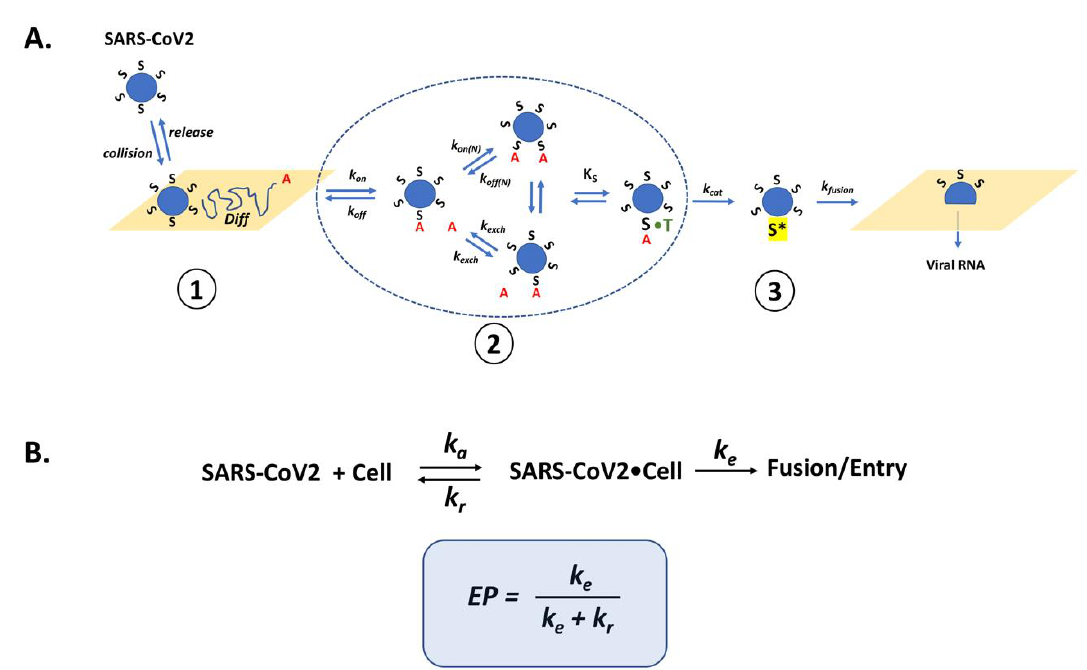
Figure 4. Kinetic Model of SARS-CoV2 Cell Interactions. (A) The model is presented as the composite of three general processes: (1) Initial collision and release from the cell surface (represented by the yellow plane) coupled to random diffusion. (2) Reversible binding of Spike protein (S) to ACE2 ( A ) (defined by kinetic constants k o n and k off ) and to TMPRSS2 (T) represented by the substrate binding constant (Ks). These events include the rebinding/exchange of one S•A complex with another ( k exch ) as well as the recruitment of additional S • A complexes ( N ) represented by k on(N) /k off(N) . (3) The irreversible proteolytic cleavage of Spike by T to its fusion form S*, represented by k cat , and the fusion of Spike with the cell membrane ( k fusion ). Additional terms can be added to describe the nonreversible endocytosis of SARS-CoV2 and cleavage of Spike by cathepsin in endosomal compartments. ( B ) The Entry Probability (EP) describes the likelihood that a SARS-CoV2 particle will enter a cell after it has collided with a target cell based on a simple kinetic model describing the lumped processes of virus association ( k a ) and release ( k r ) from the cell as well as fusion and entry ( k e ). Thus, the EP is based on the ratio of the pseudo first order rate constant of SARS-CoV2 entry into the cell ( k e ) after Spike-mediated fusion (Process (3)) and virus release from the cell surface ( k r ) either before or after various S•A and S•T complexes have formed (combination of Processes (1) and (2)).